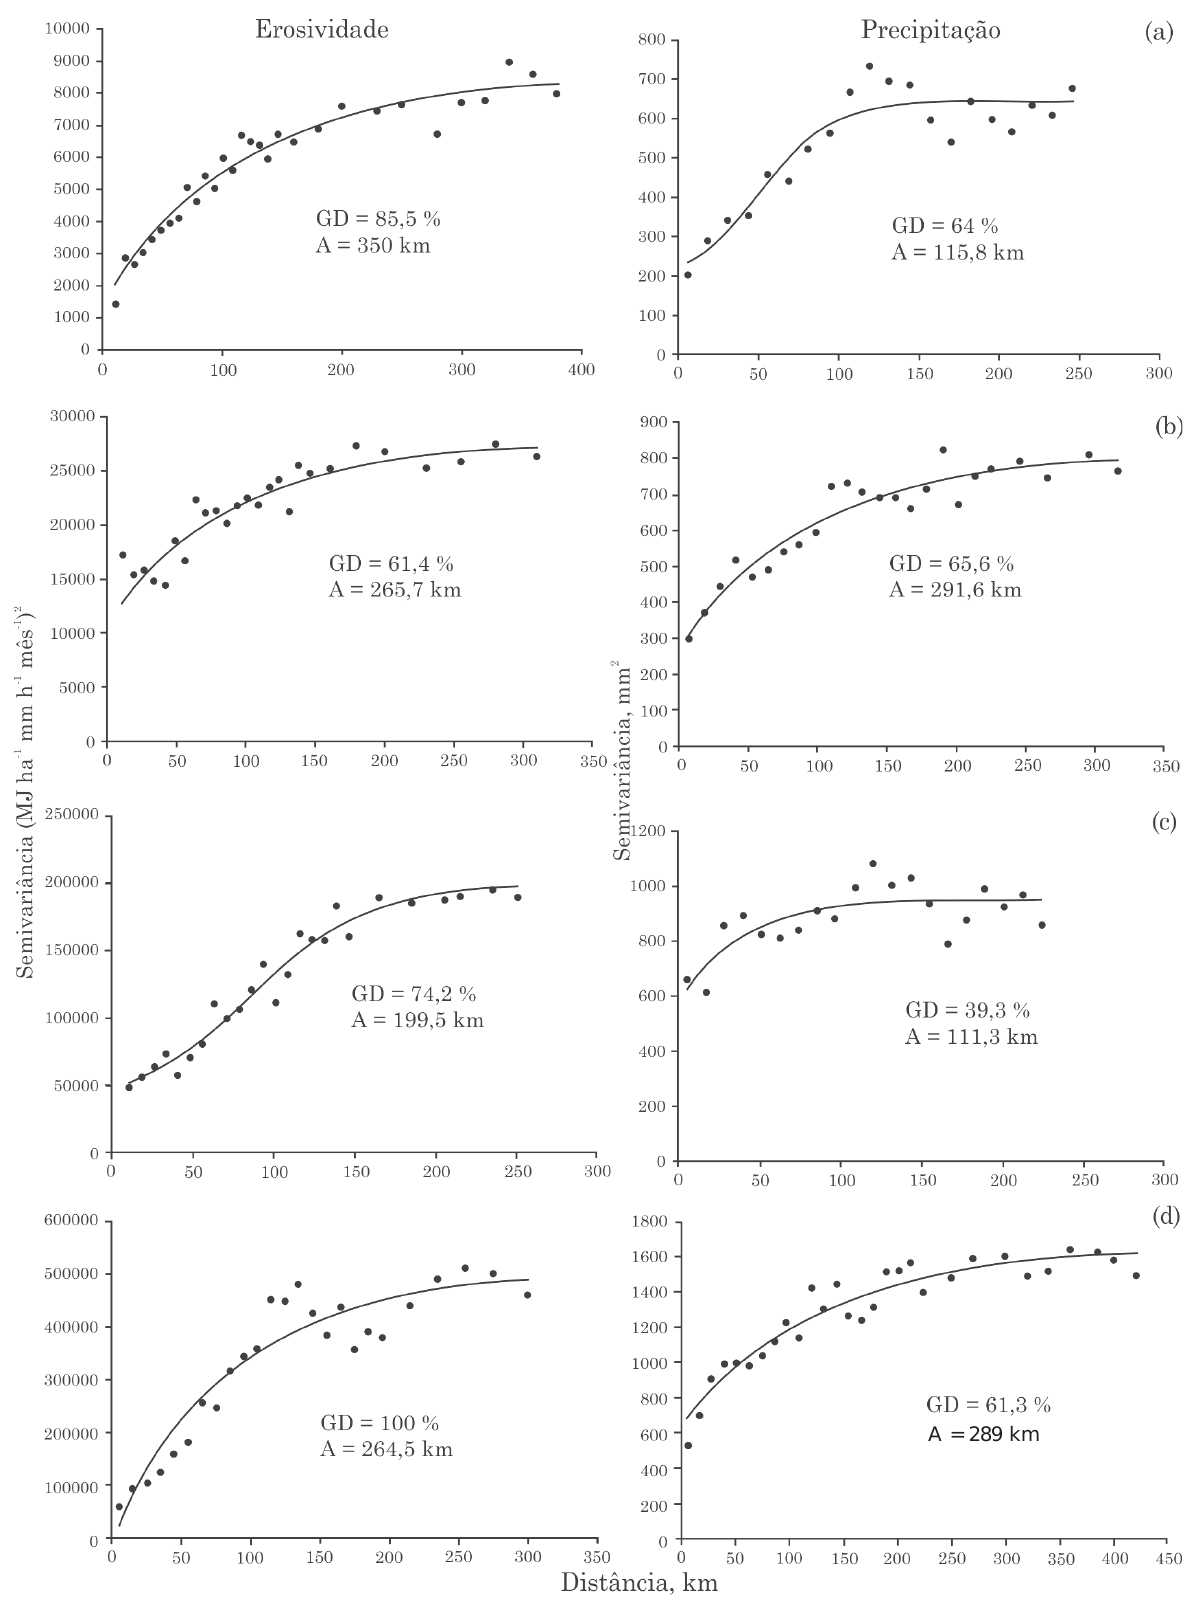
Figura 6. Semivariogramas ajustados para erosividade e precipitação mensais para o Estado do Espírito Santo (a) setembro; (b) outubro; (c) novembro; (d)